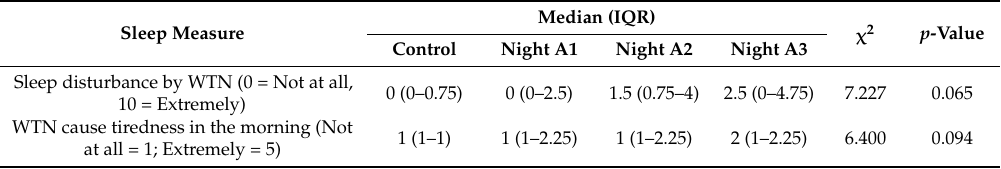
Table 6. Objective sleep variables where a main effect of WTN sound character period was found in Table 5. Self-reported sleep variables where a main effect of night was found in Study Study B.